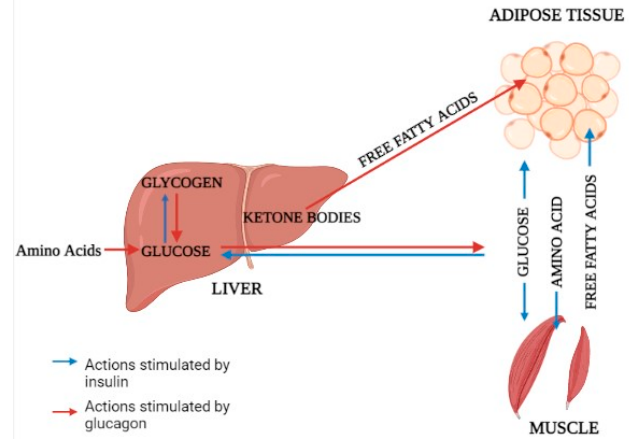
Figure 1. Interaction between liver and muscle tissues.